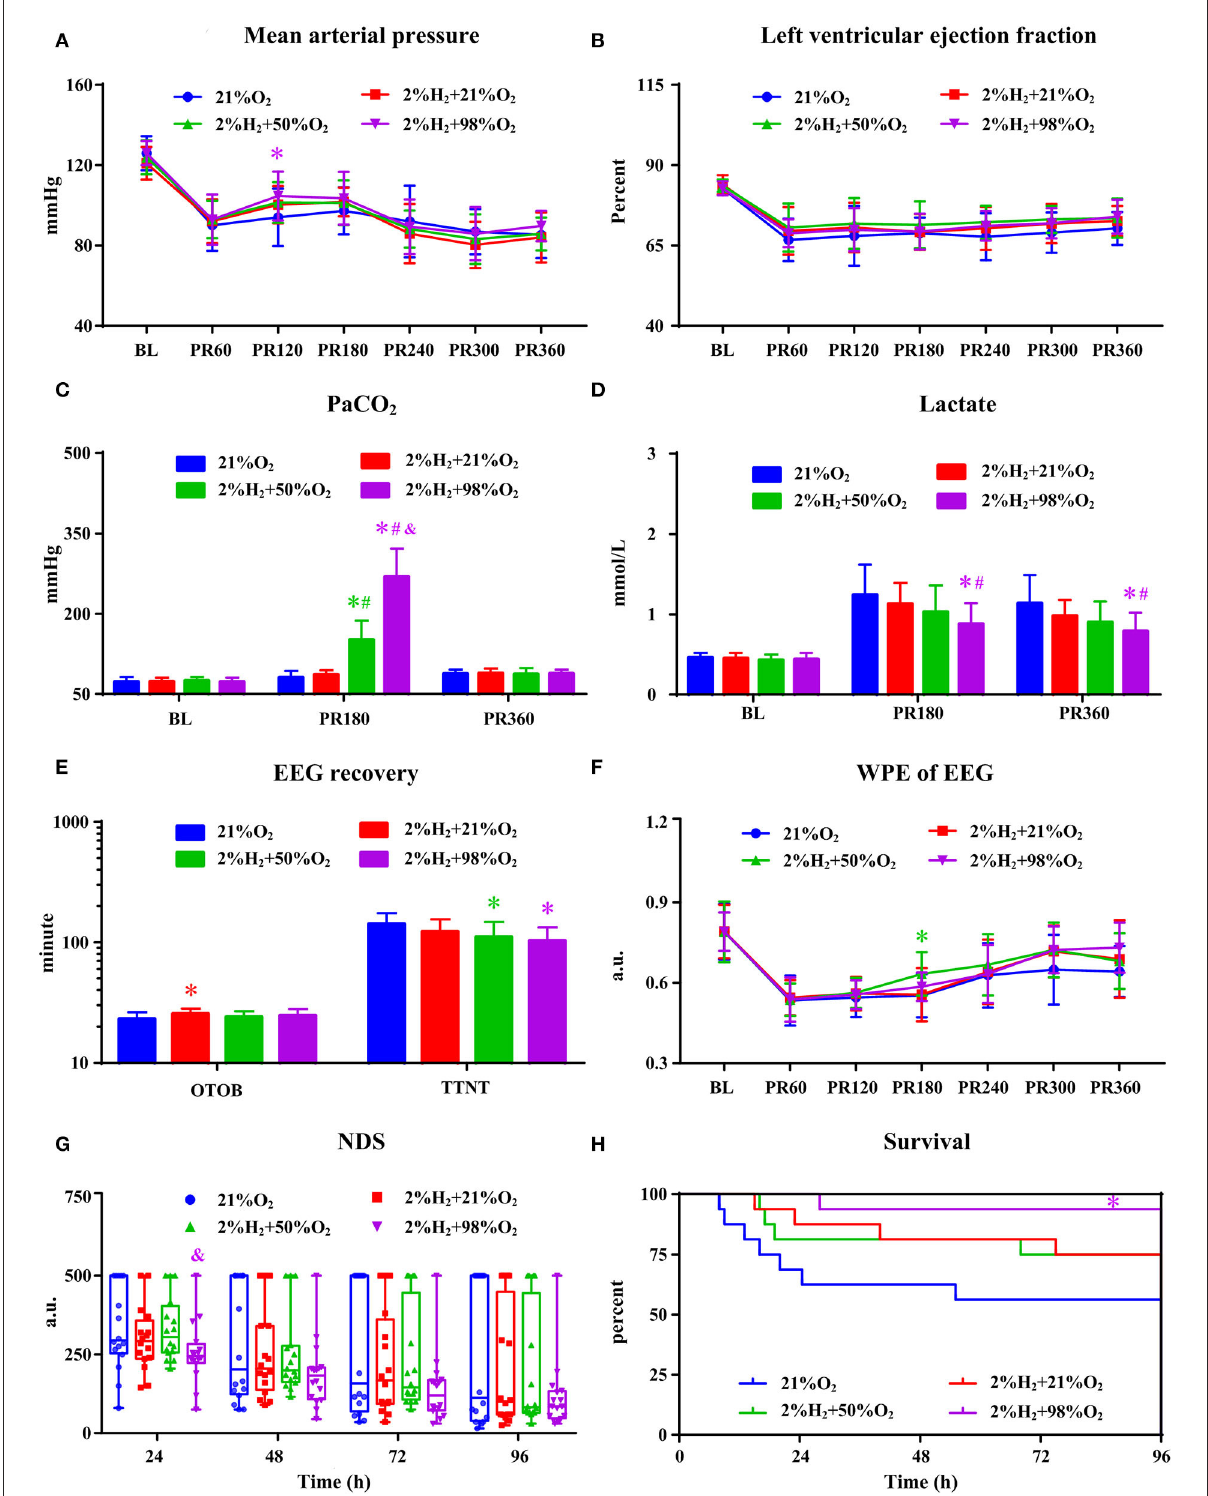
FIGURE4 The hemodynamic and neurological data in animals under hypothermia. (A) Mean arterial pressure (MAP), (B) left ventricular ejection fraction (LVEF), (C) PaO 2 , (D) lactate, (E) EEG recovery, (F) weighted-permutation entropy (WPE) of EEG, (G) neurological deficit score (NDS), and (H) survival curve. BL, baseline; PR, post-resuscitation. * p < 0.05 vs. 21%O 2 group; # p < 0.05 vs. 2%H 2 + 21%O 2 group; & p < 0.05 vs. 2%H 2 + 50%O 2